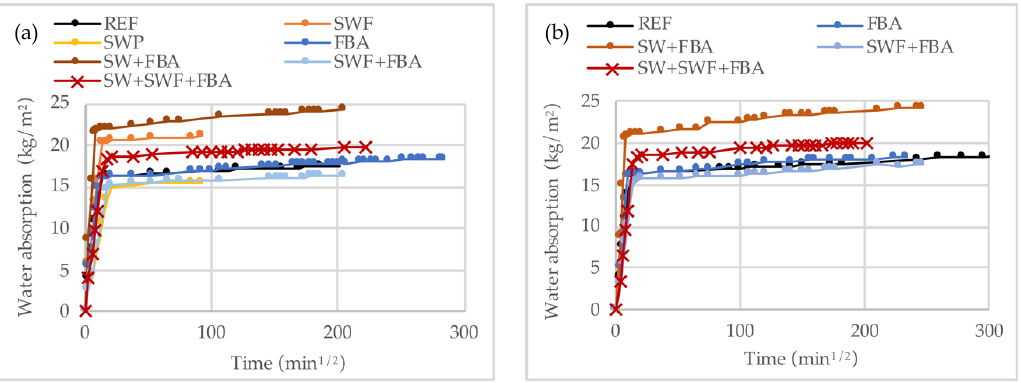
Figure 1. Water absorption curves at 28 days ( a ) and 365 days ( b ).